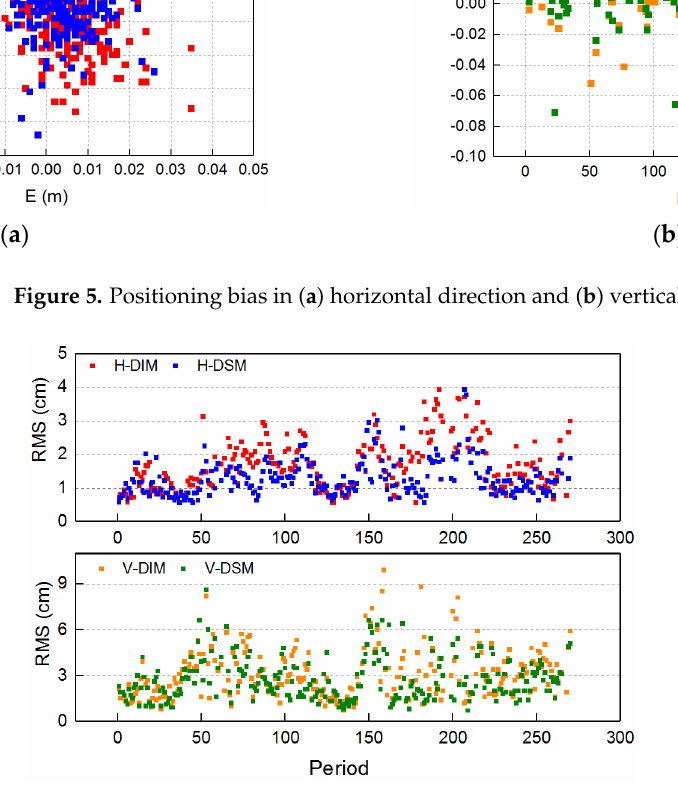
Figure 6. RMS values of horizontal (H) and vertical (V) directions after convergence.